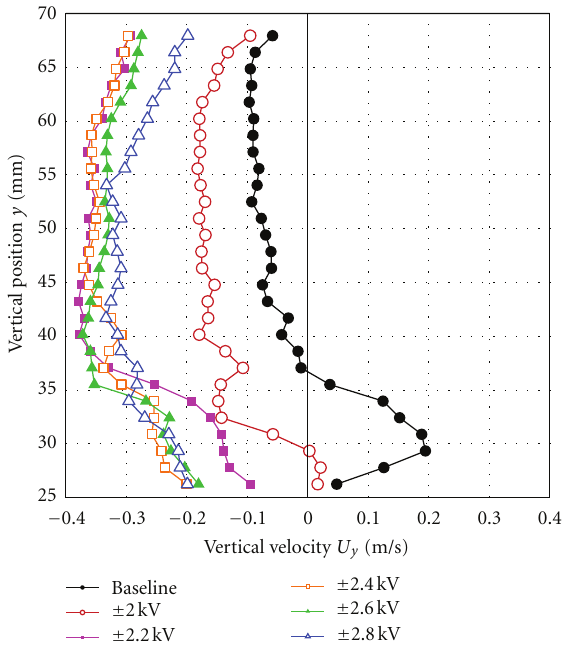
Figure 13: Vertical velocity distributions near trailing edge ( x = 99.1mm).